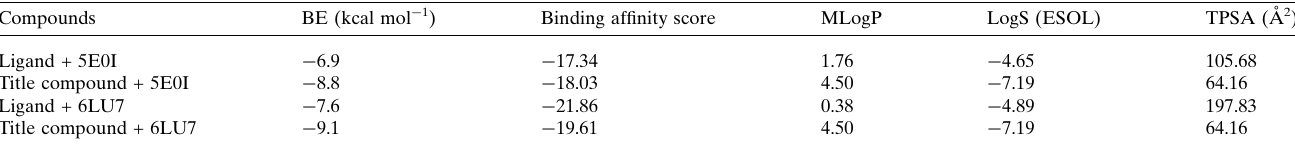
Table 4 Basic characteristics of molecular docking. Compounds